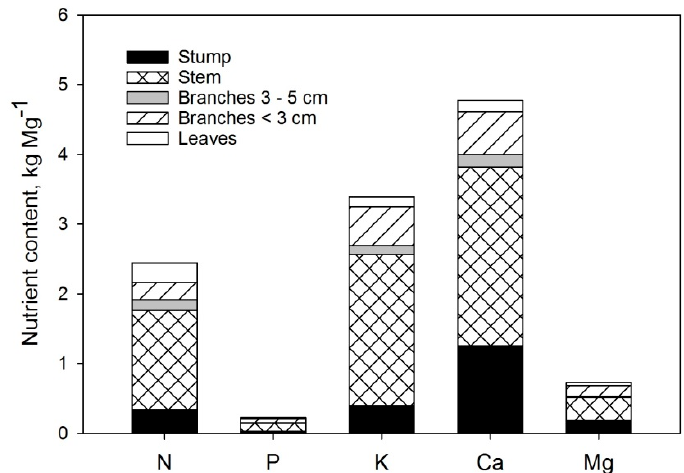
Figure 1. The content of N, P, K, Ca, and Mg bound in rubber tree biomass, by compartments, in plantations in southern Thailand.